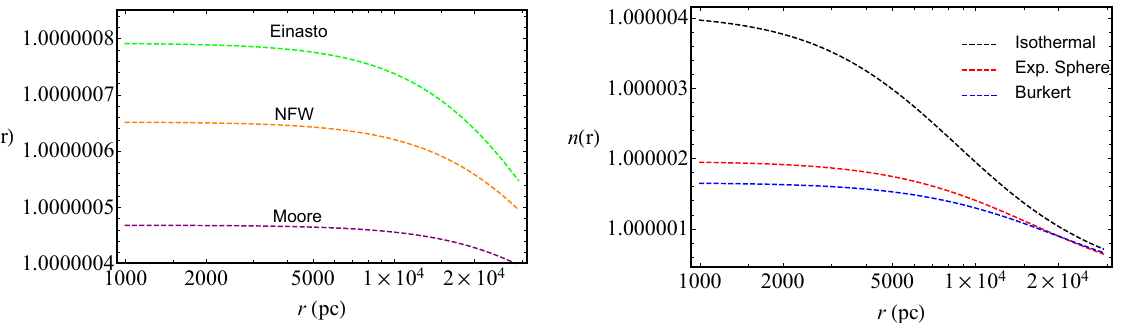
Figure 2. Color online. The refractive index for DM in galaxy ESO0140040. Left panel: The refractive index of the Einasto, NFW and Moore profiles. Right panel: The refractive index of the ISO, exponential sphere and Burkert